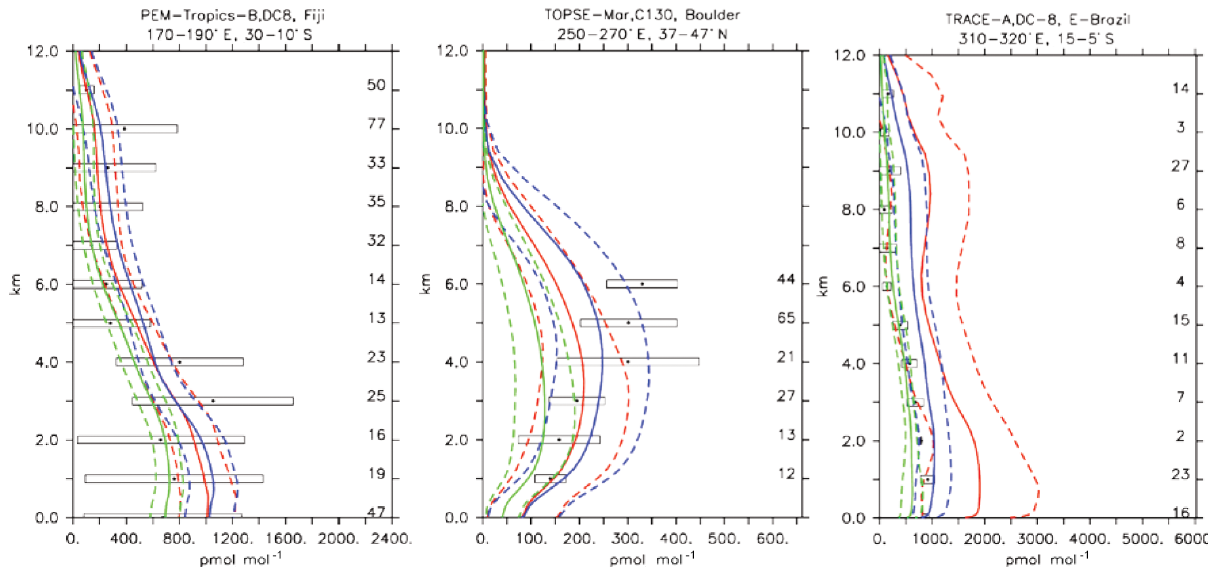
Figure 14. Comparison of simulated CH 3 OOH vertical profiles by using the CBA (red), MOC (blue) and MOZ (green) chemistry versions against aircraft data (black). Line styles and symbols have the same meaning as in Fig.